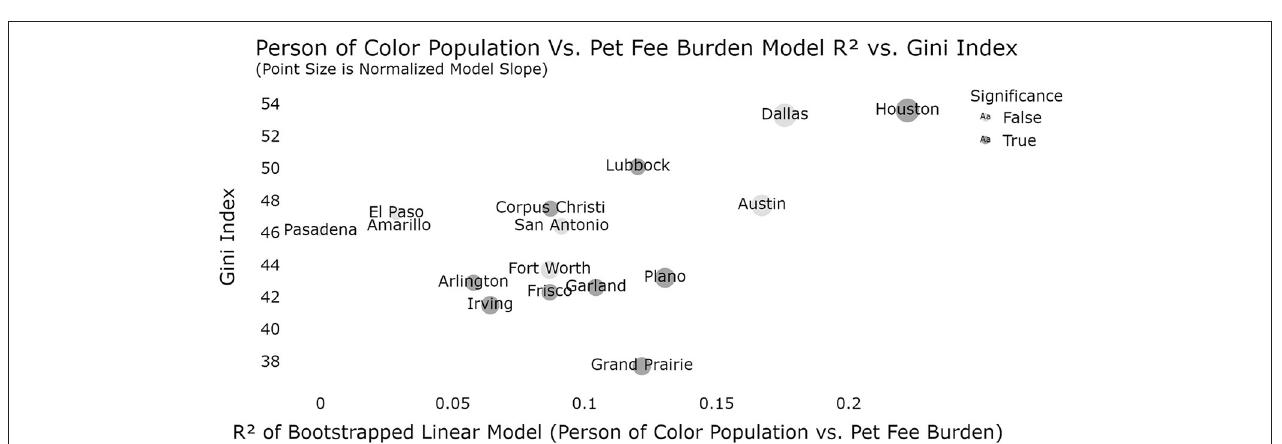
FIGURE 5 | Relationship between proportion of people of color by Gini index by city with model effect size (dark gray is significant models; p < 0.05). Note that Houston is the city in which the evidence is strongest that inequality may be, in some way, related to the degree to which pet fee burdens can be predicted by racial makeup of the census